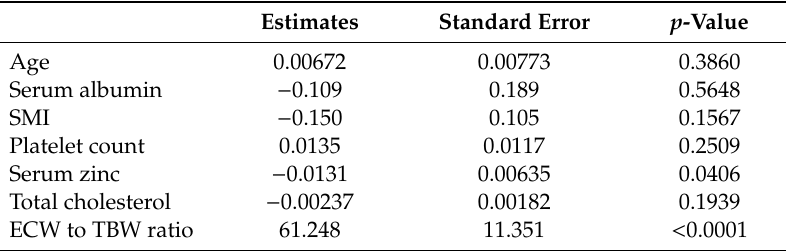
Table 4. Multivariate analyses of factors linked to frailty score for